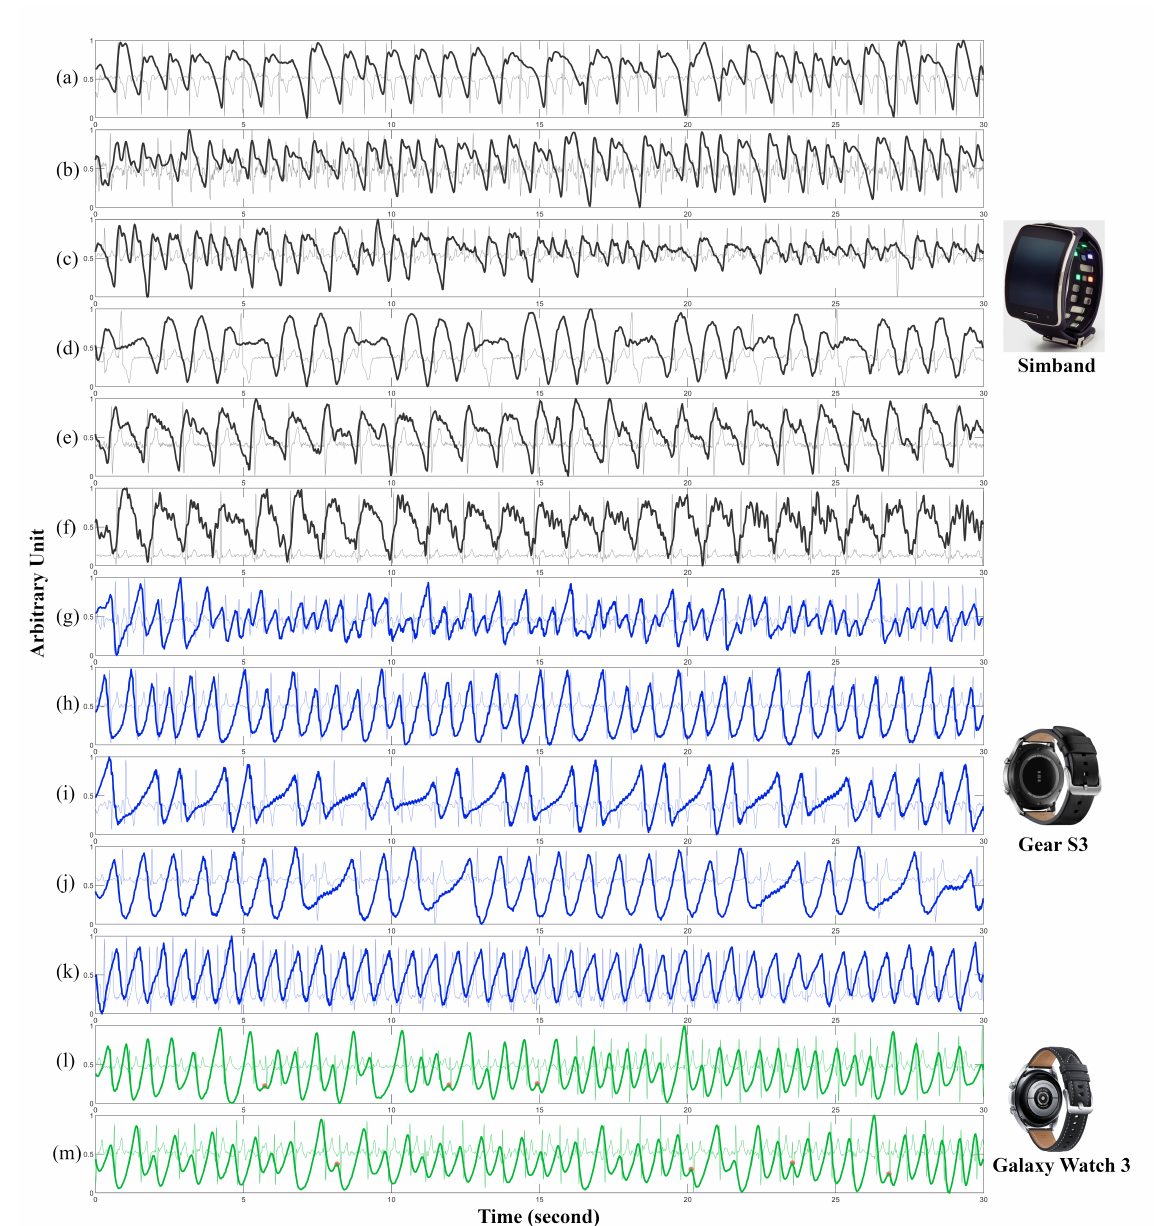
Figure 9. Example signal traces from three different types of watches and different types of ar- rhythmias. PPG signals are shown in the foreground, and reference ECG signals are plotted in the background. Panels ( a – f ): raw PPG signals collected with Simband and from AF ( a – c ), PVC ( d ), NSR ( e , f ). Panels ( g – k ): raw PPG signals (baseline wander removed) collected with Gear S3 (2016) and from AF ( g , h ), PAC ( i ), PVC ( j ), and NSR ( k ). Panels ( l , m ): raw PPG signal (baseline wander removed) collected with Galaxy Watch 3 (2020) and from AF participants. The dicrotic-notch like PPG peaks marked in red in panels ( l , m ) should be detected as true peaks as they correspond to actual AF beats shown in the background reference